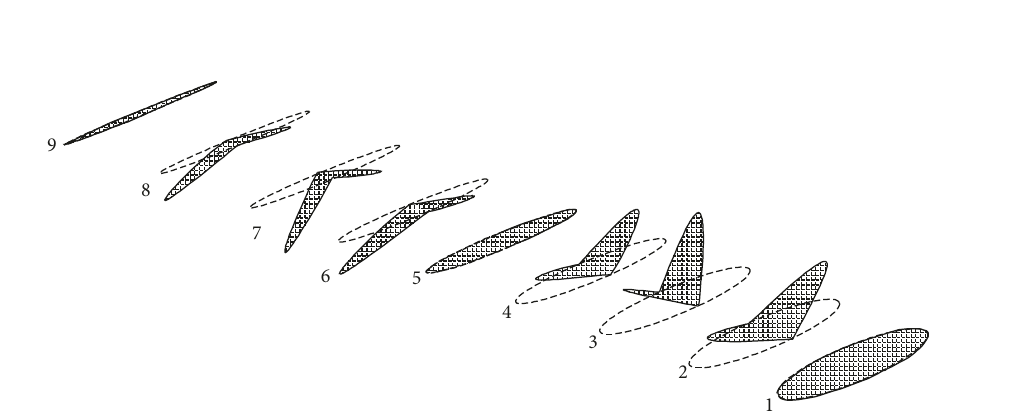
Figure 4: The movement of the bird-like flapping wing